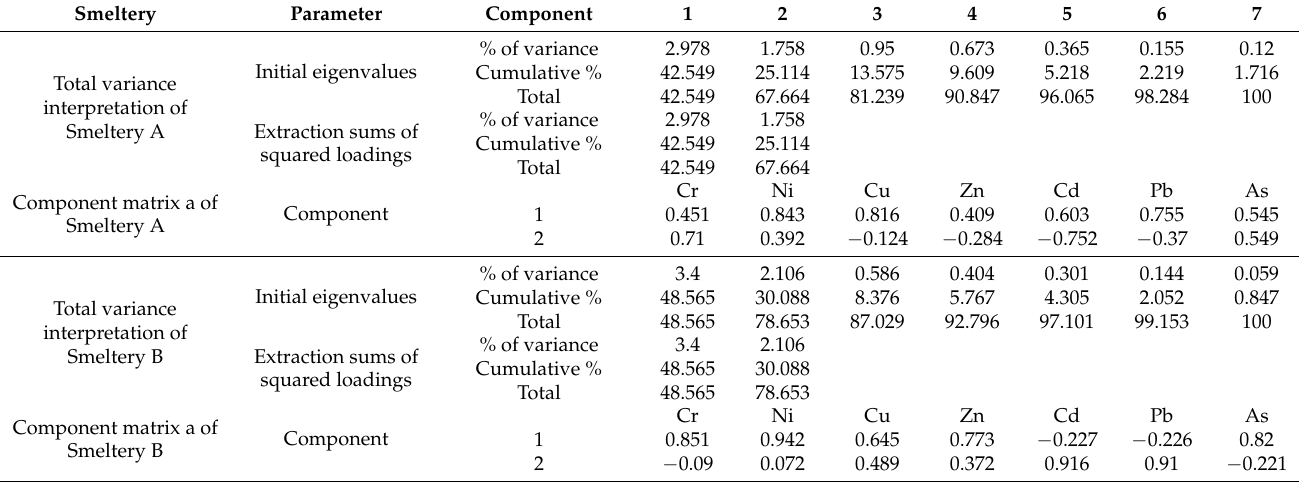
Table 4. Eigenvalues, contribution rates, and component matrix of principal